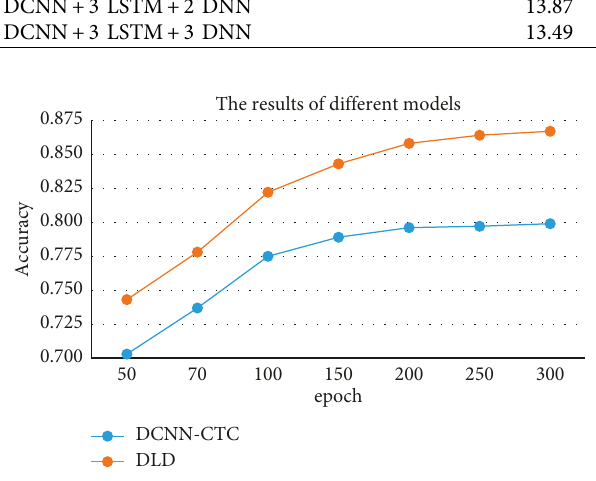
Figure 5: The accuracies of DCNN-CTC and DLD.